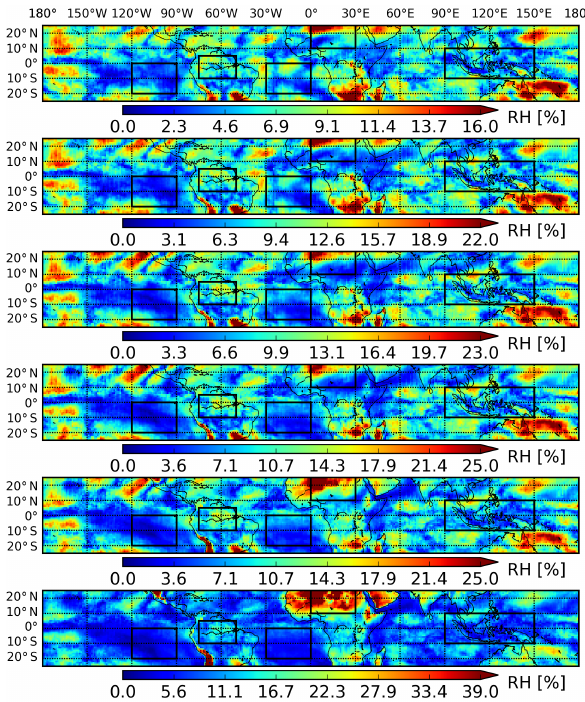
Figure 11. Spatial distribution of diurnal amplitude of RH I for the months of December and January. Depicts from top to bottom are for SAPHIR channels 1–6,